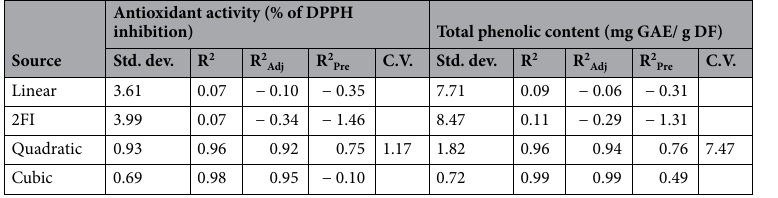
Table 3. Adequacy of the model tested for the